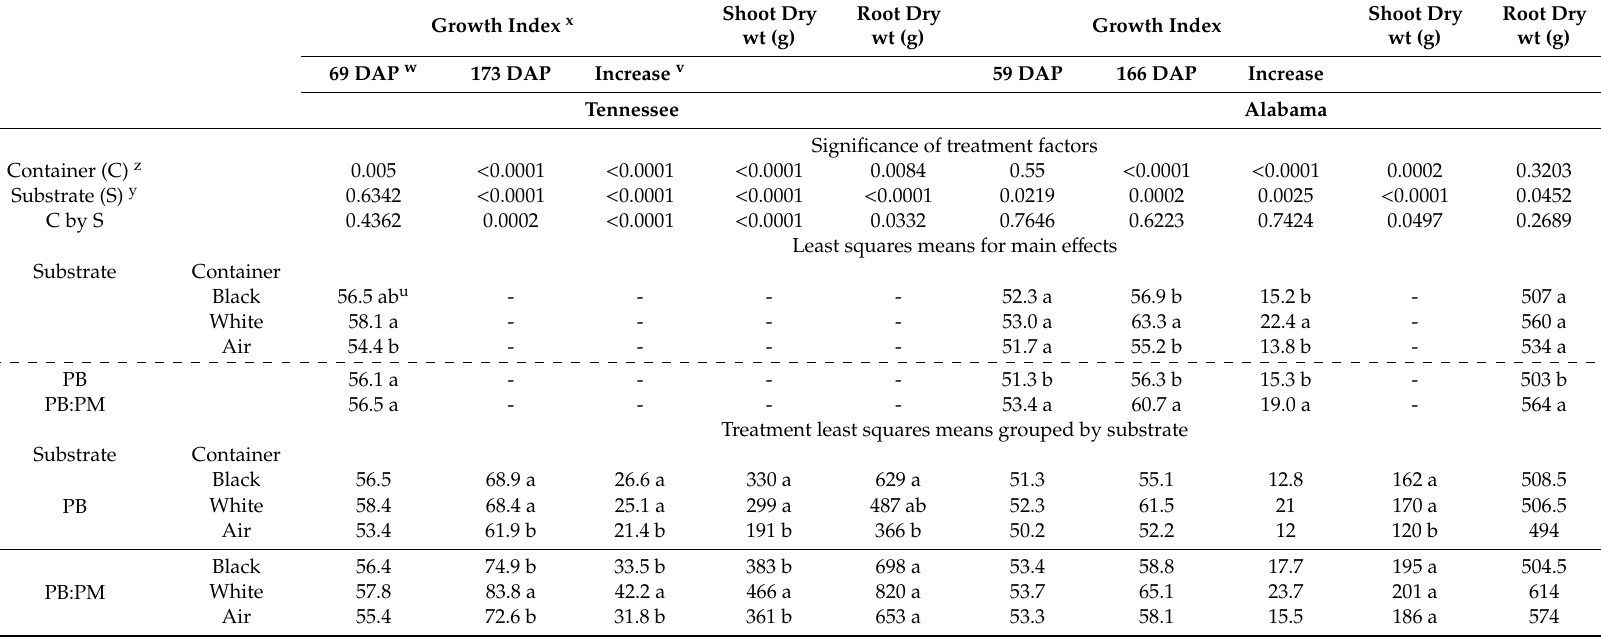
Table 2. Plant growth index (n = 12), growth index increase and dry weight (shoot and root) of ‘Green Giant’ arborvitae grown in di ff erent types of containers and substrates in Tennessee and